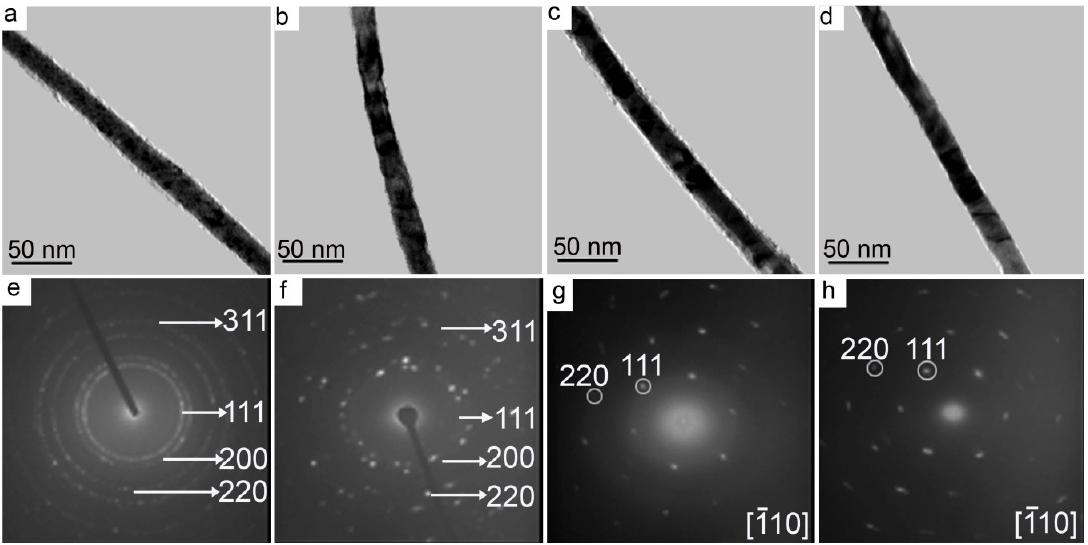
Figure 3. Typical ( a – d ) TEM images and ( e – h ) corresponding SAED patterns of a single Ni nanowire that deposited under current densities of ( a , e ) 1.2 mA/cm 2 , ( b , f ) 1.5 mA/cm 2 , ( c , g ) 2.0 mA/cm 2 , ( d , h ) 2.5 mA/cm 2 .